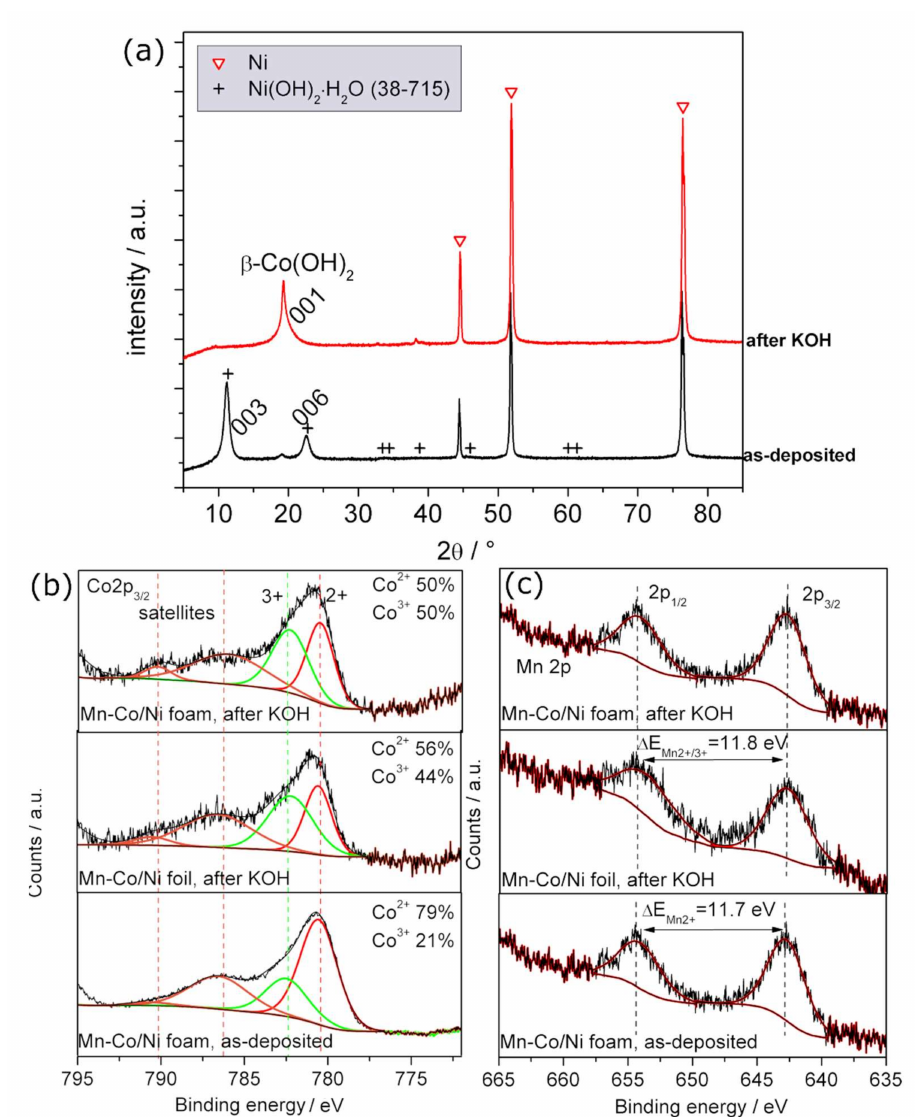
Figure 2. ( a ) XRD patterns of Mn-Co deposited on nickel before (red, triangle), and after (black, cross) alkaline treatment. The most intense di ff raction peaks are assigned to Ni foil. XPS scans of ( b ) Co and ( c ) Mn of as-deposited and after-alkaline-treatment Mn-Co film. For XRD and XPS, the film was synthesised in a solution of Mn / Co 2 mM / 8 mM for 200 mC on nickel foam /